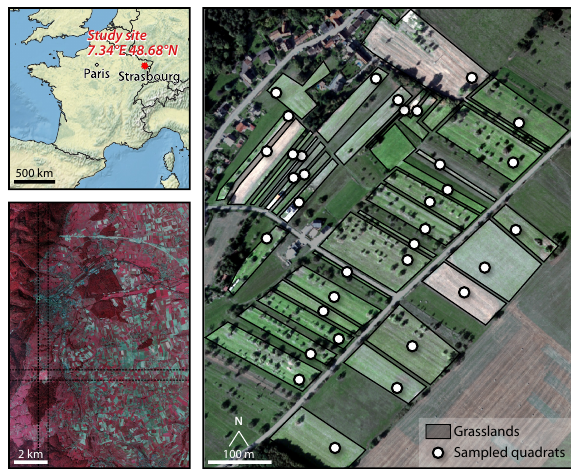
Figure 1. Study site location and surroundings. Infrared false color (bottom left panel) and natural color (right panel) images are provided for visualization.